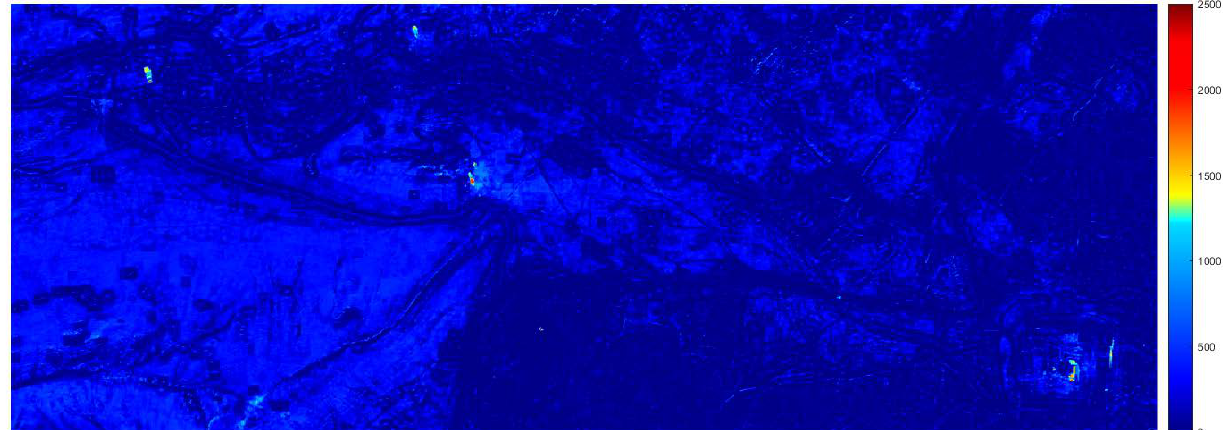
Figure 4. Robust change